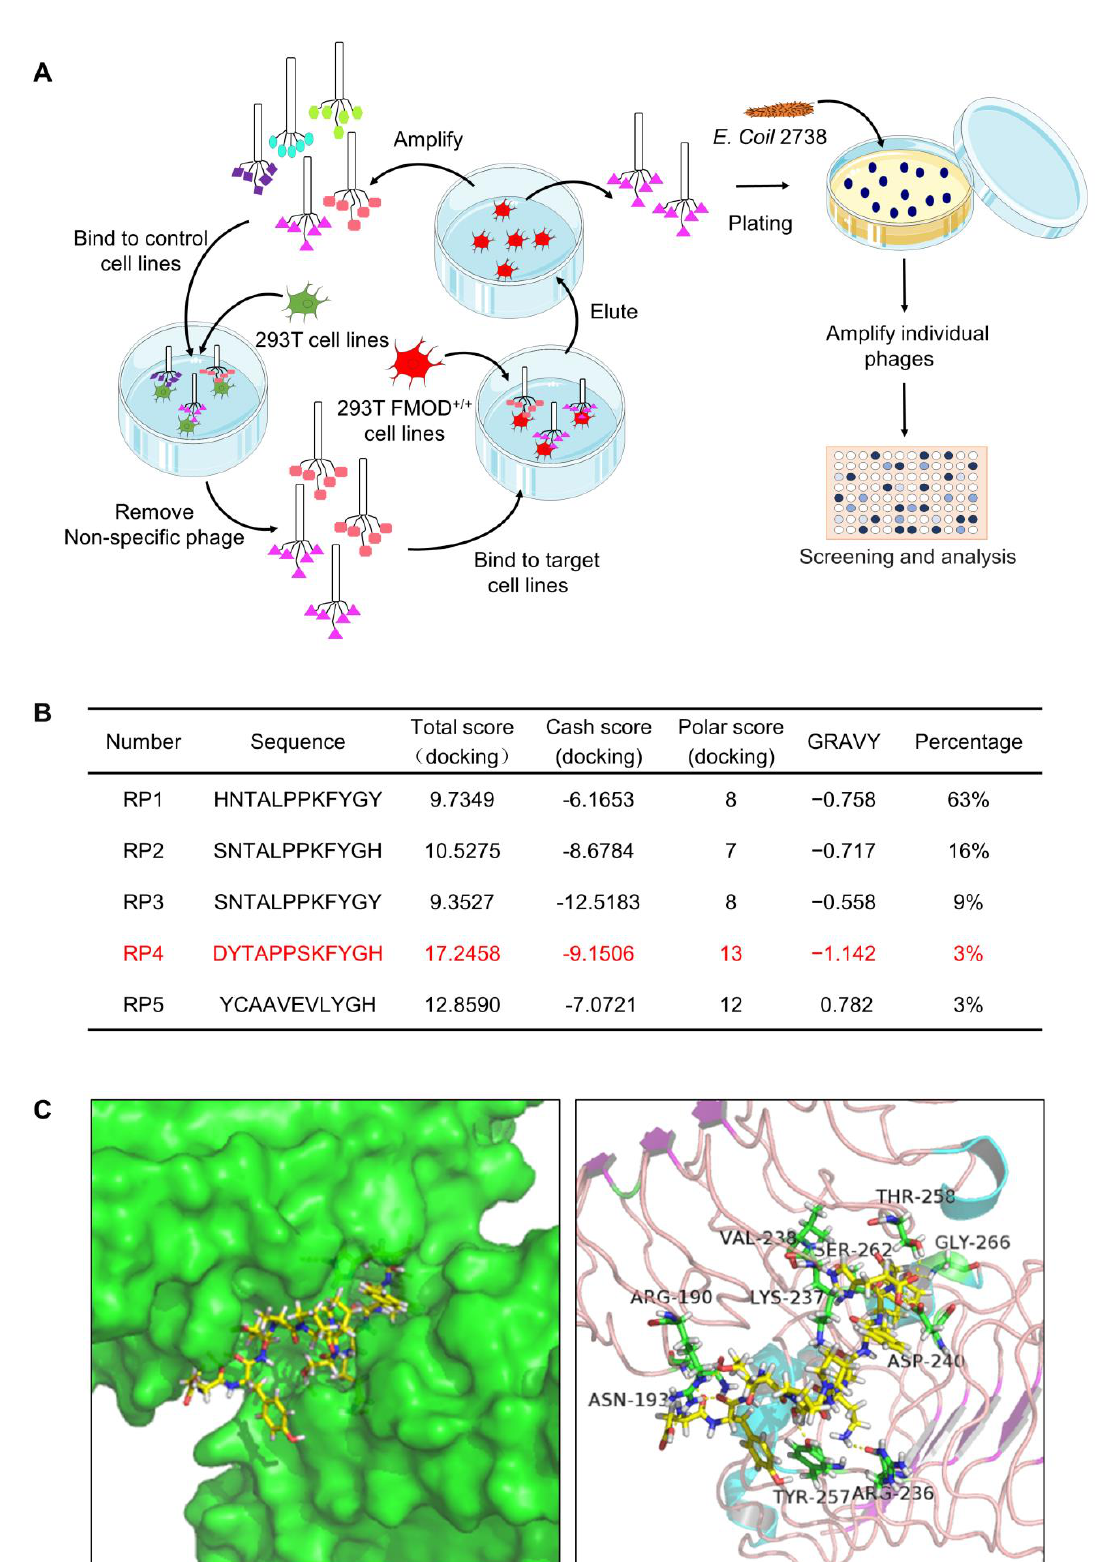
Figure 2. Biopanning process of FMOD antagonist peptides. ( A ), Panning procedure in phage display technology. ( B ), The data of grand average of hydropathy and docking score, including total score, cash score, and polar score. ( C ), Combined simulation of FMOD and RP4 by SYBYL 8.0 software (Tripos, St. Louis, MO,